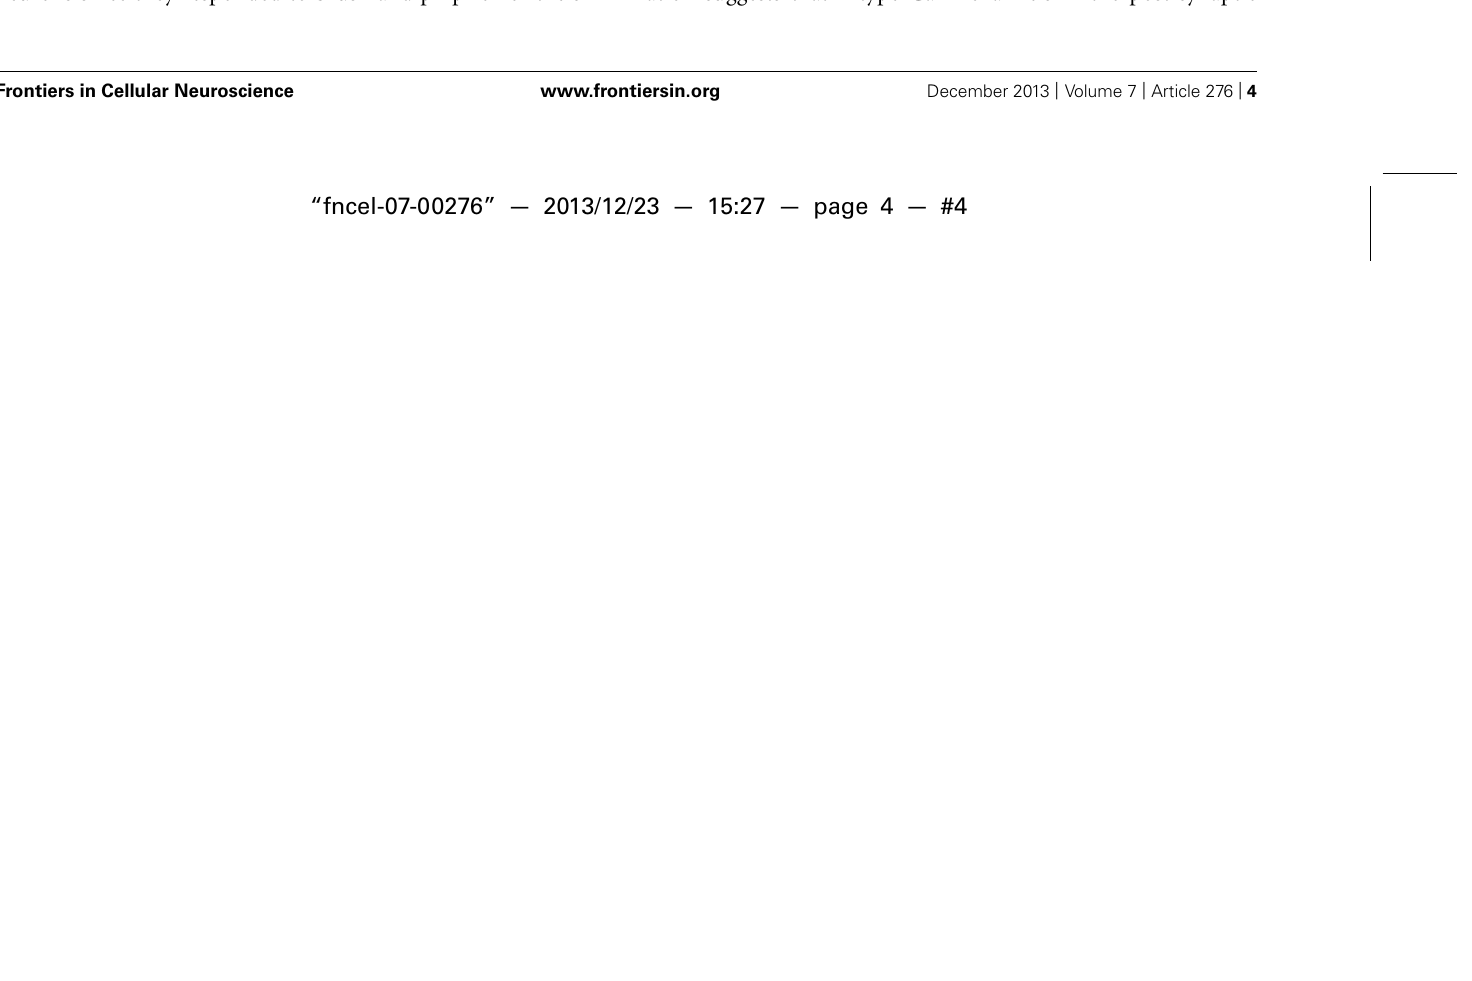
( Figure 4C ). In 11 of 47 cells, the response to skin brush con- sistedof subthresholdEPSPsmixedwithsomeIPSPs( Figure4Ab